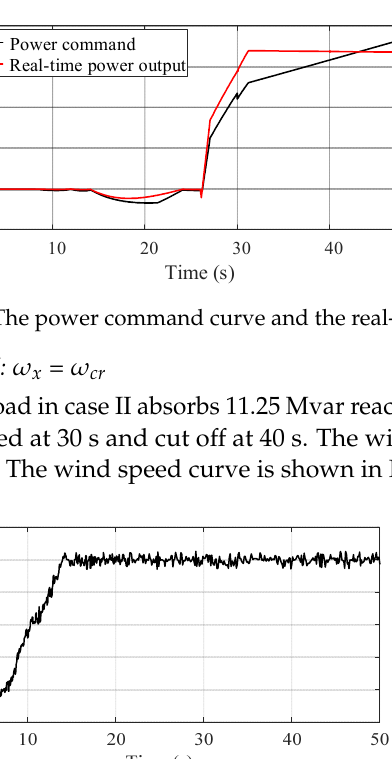
Figure 18. The output power of LIB and SC. ( a ) Output power of LIB. ( b ) Output power of SC.